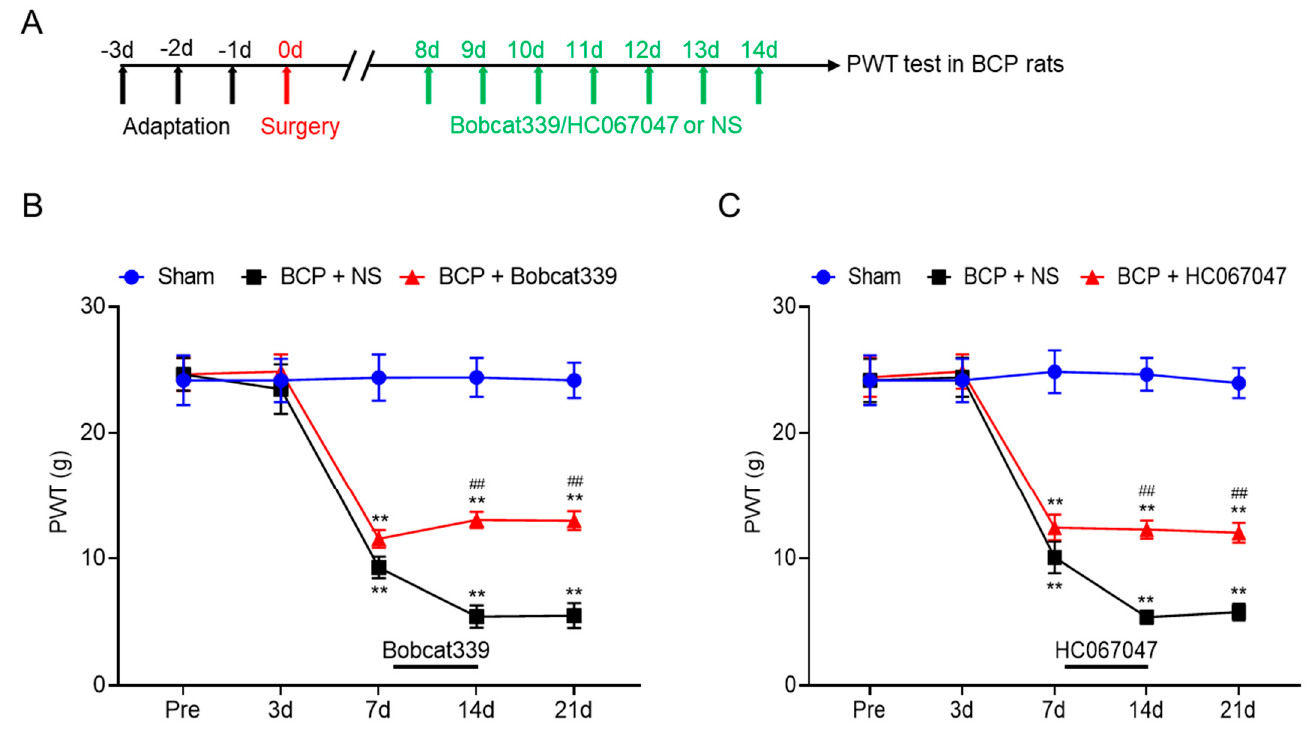
Figure 7. TET1 inhibitor Bob339 or TRPV4 inhibitor HC067047 alleviated mechanical allodynia in BCP rats. ( A ) The schematic diagram. ( B ) Bobcat339 was intrathecally injected on the 8th day after tumor cell inoculation for 7 consecutive days. Compared with the BCP + NS group, the allodynia of BCP rats was significantly partially reversed (** p < 0.01 vs. sham, ## p < 0.01 vs. BCP + NS, n = 8,